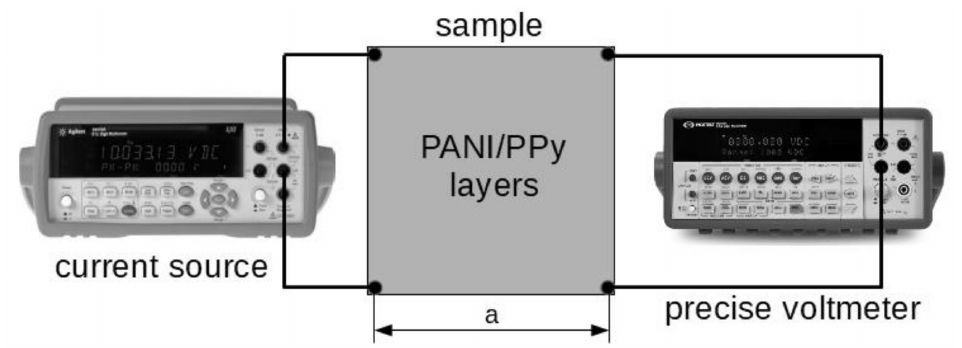
Figure 1. Stand for testing the surface resistance of textile samples with conductive polymers PANI and